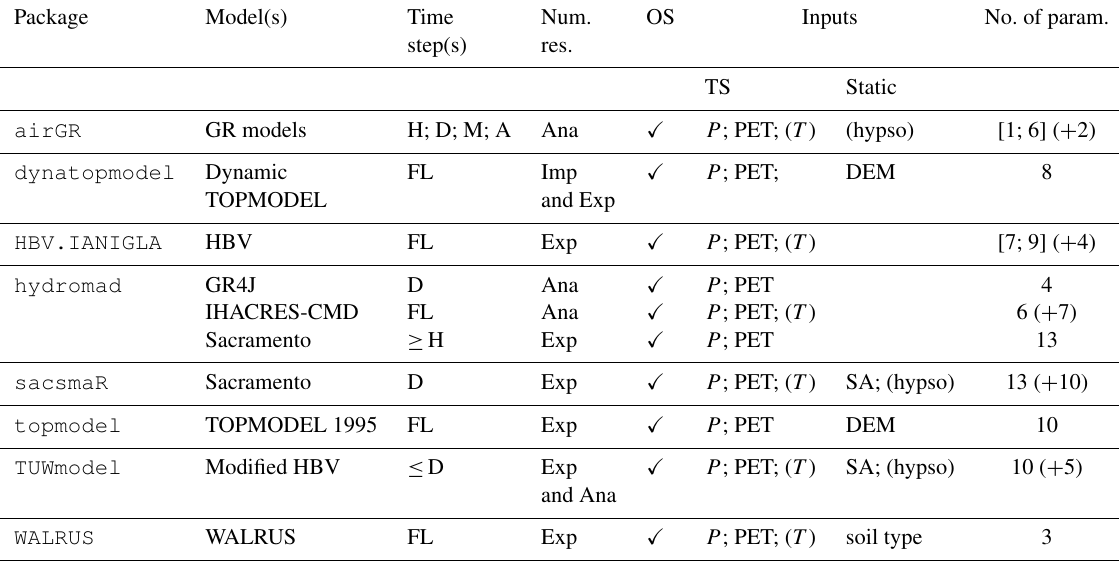
Table 4. Requirements to run the models and associated numerical resolutions. Note: D – daily; H – hourly; M – monthly; A – annual; FL – flexible; Num. res. – numerical resolution; OS – operator splitting; Ana – analytic; Exp – explicit; Imp – implicit; P – precipitation; T – air temperature; PET – potential evapotranspiration; DEM – digital elevation model; SA – subbasins area; hypso – hypsometric curve; TS – time series. The information in parentheses shows the parameters or inputs of the corresponding snow routine. It is not compulsory to provide the snow routines with the hypsometric curve, but it is strongly recommended when this is enabled by one of the packages. In this table, for the semi-distributed models, the parameters are considered uniform over the spatial units; in case they are considered distributed, the amount of parameters should be multiplied by the number of spatial units (i.e. HRUs, subbasins, etc.).